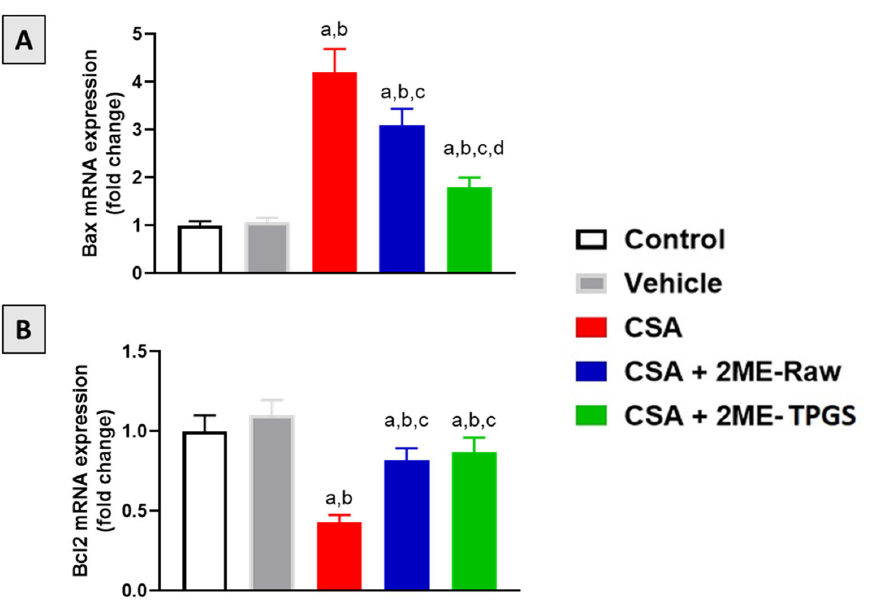
Figure 6. Effect of 2ME-TPGS on kidney mRNA expression of Bax ( A ) and Bcl-2 ( B ) in CSA-treated rats. Data presented in bar charts are expressed as mean ± SD ( n = 6). a, b, c, or d: significantly different when compared with respective Control, Vehicle, CSA, or CSA + 2ME-Raw at p < 0.05, respectively.